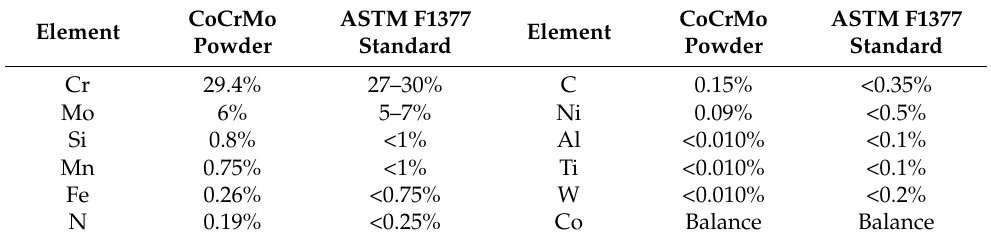
Table 2. Comparison of powder materials used in SLM and ASTM F1377 standard.